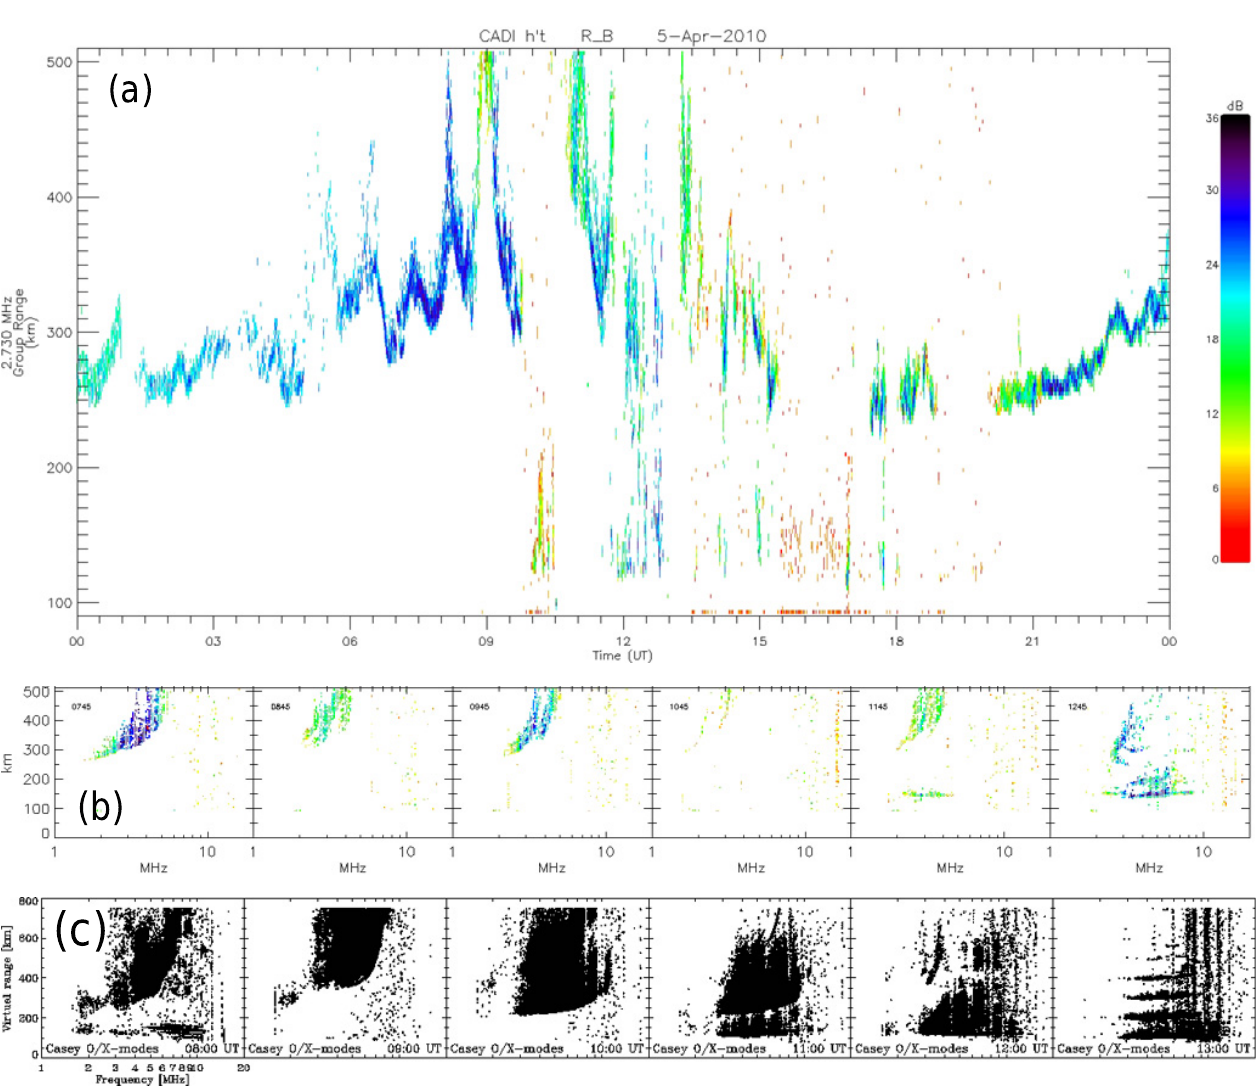
Fig. 10. (a) Fixed frequency and (b) swept frequency ionograms from Resolute Bay and (c) ionograms from Casey on 5 April 2010.